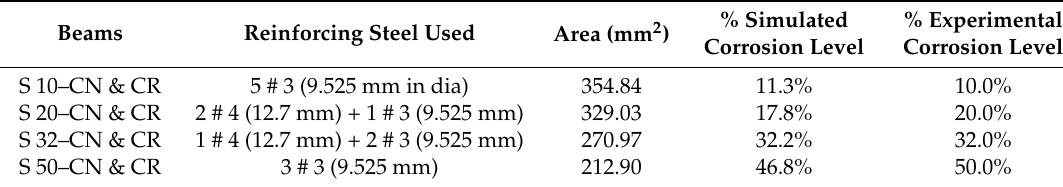
Table 3. Simulated corrosion. S: Simulated. #: